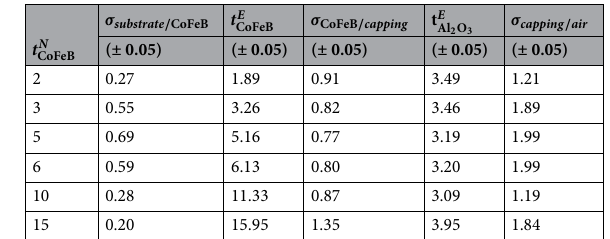
N CoFeB ) and GenX 26 extracted thickness (